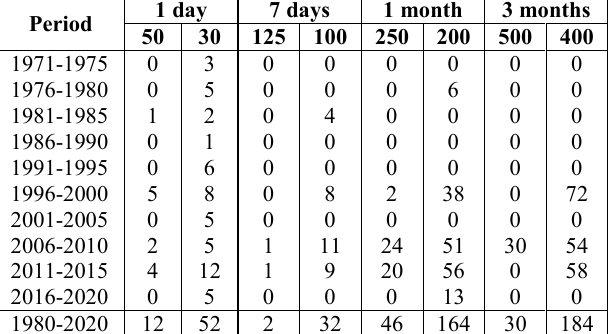
Table 7. No. days in which a rainfall (mm) has been